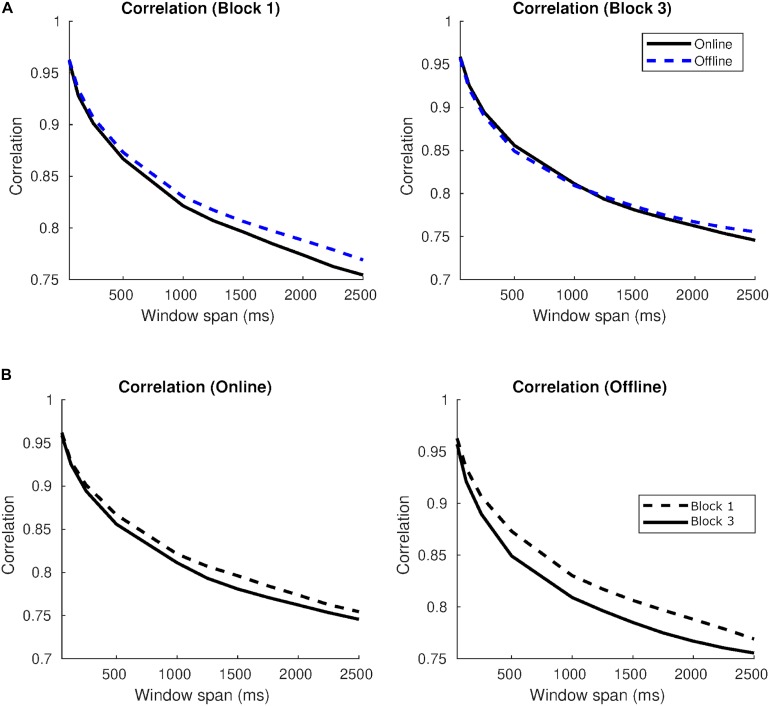
Correlations in auditory blocks and per type of agent in Study 2. (A) Correlation indices in block 1 (left) and block 3 (right) per type of agent as a function of the window span. (B) Correlation indices per online agent (left) and offline agent (right) in block 1 and block 3.